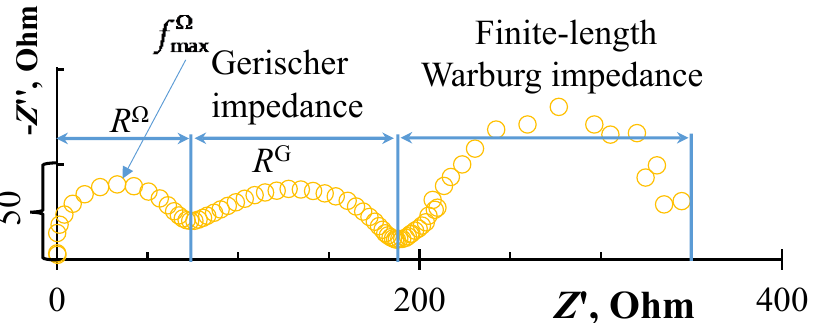
Figure A1. Typical impedance spectrum of a monopolar ion-exchange membrane and adjacent diffusion layers in the over-limiting current mode. Its shape is mainly determined [96,108] by electrical capacitances and Ohmic resis- tances of the layers in the membrane system under study (DBL/membrane/DBL). The width of the high-frequency arc is equal to R Ώ , which is the Ohmic resistance of the mem- brane and the adjacent DBLs. The maximal value of the imaginary component of impedance on this arc, − Z (cid:48)(cid:48) , and the frequency corresponding to this value, f the effective capacitance according to equation [96]: